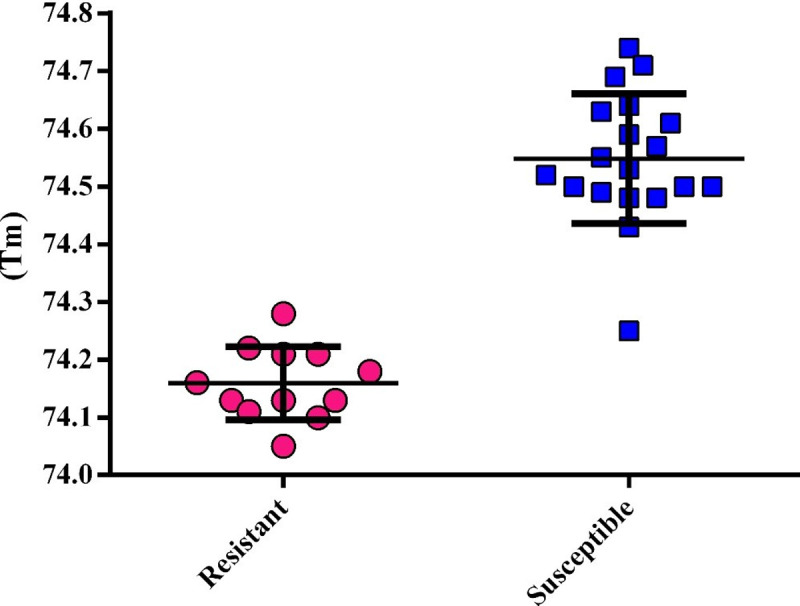
The scatter dot plot representing the Tm distributions among resistant and susceptible isolates.